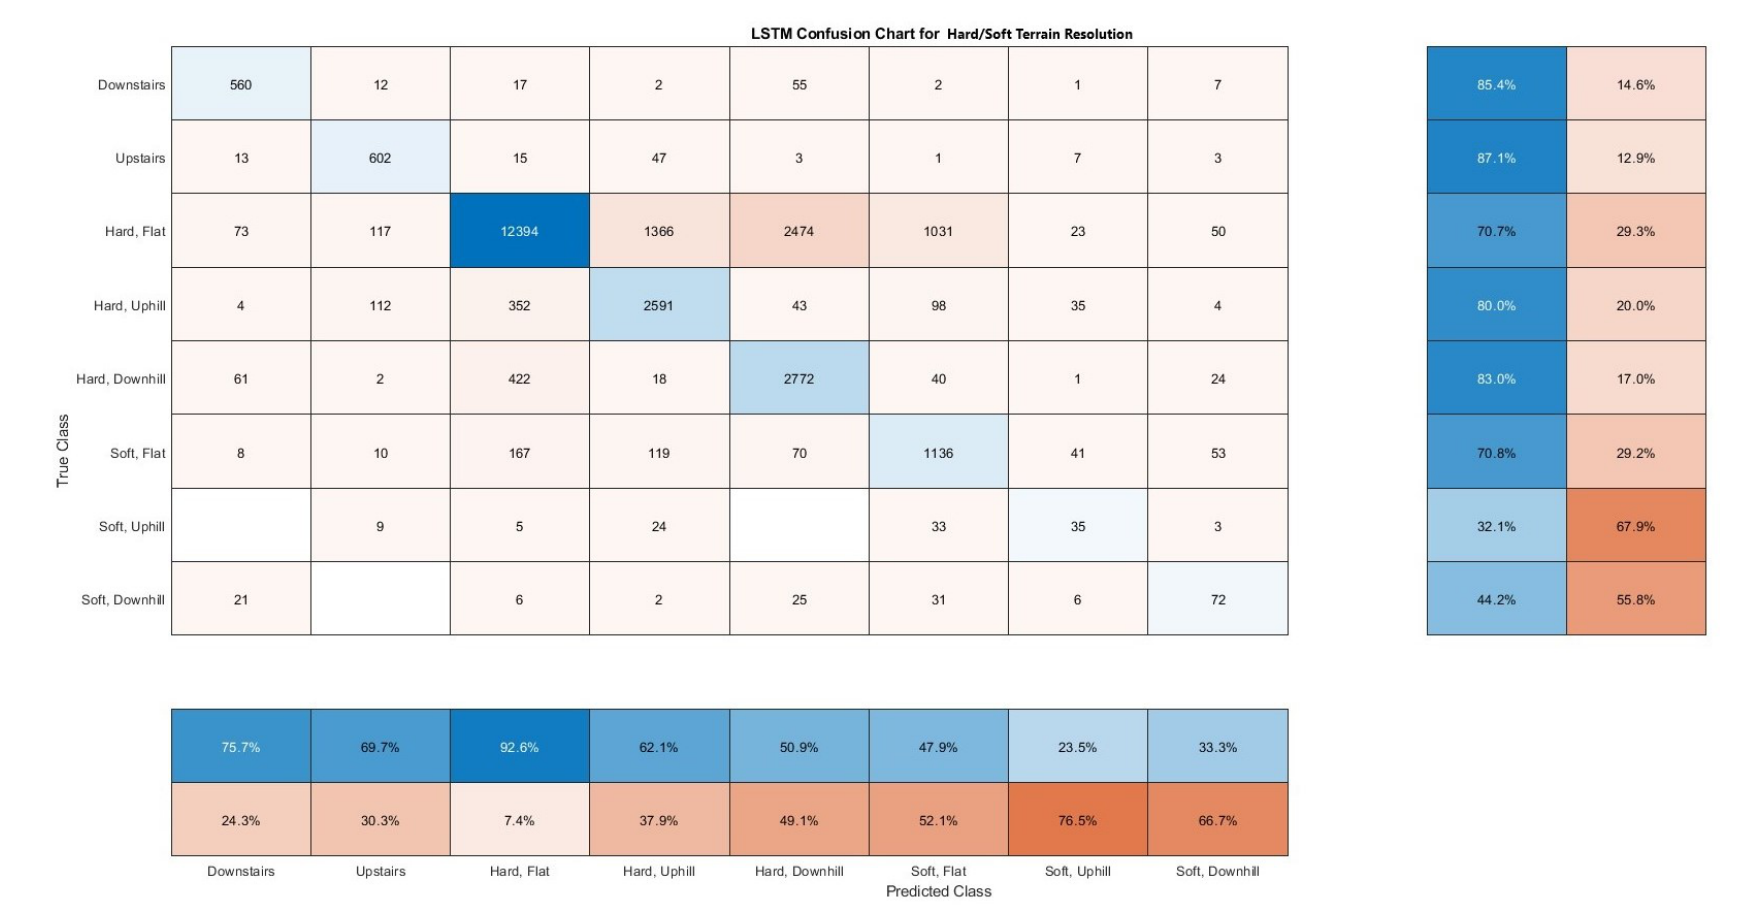
Figure A5. Long Short-Term Memory Network Confusion Chart for Level 2 label